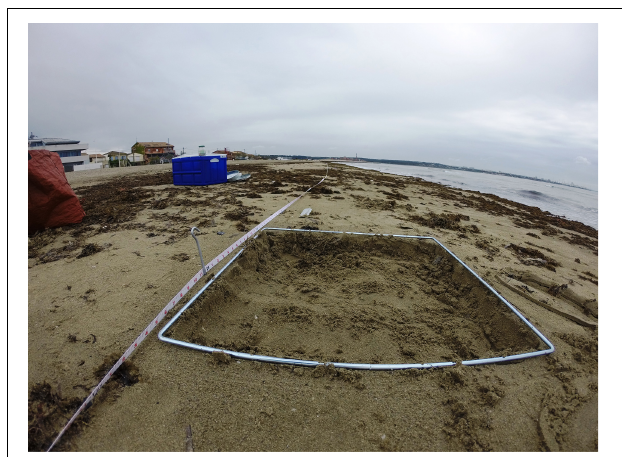
FIGURE 4 | The microplastics research site (J. Calcutt photo).